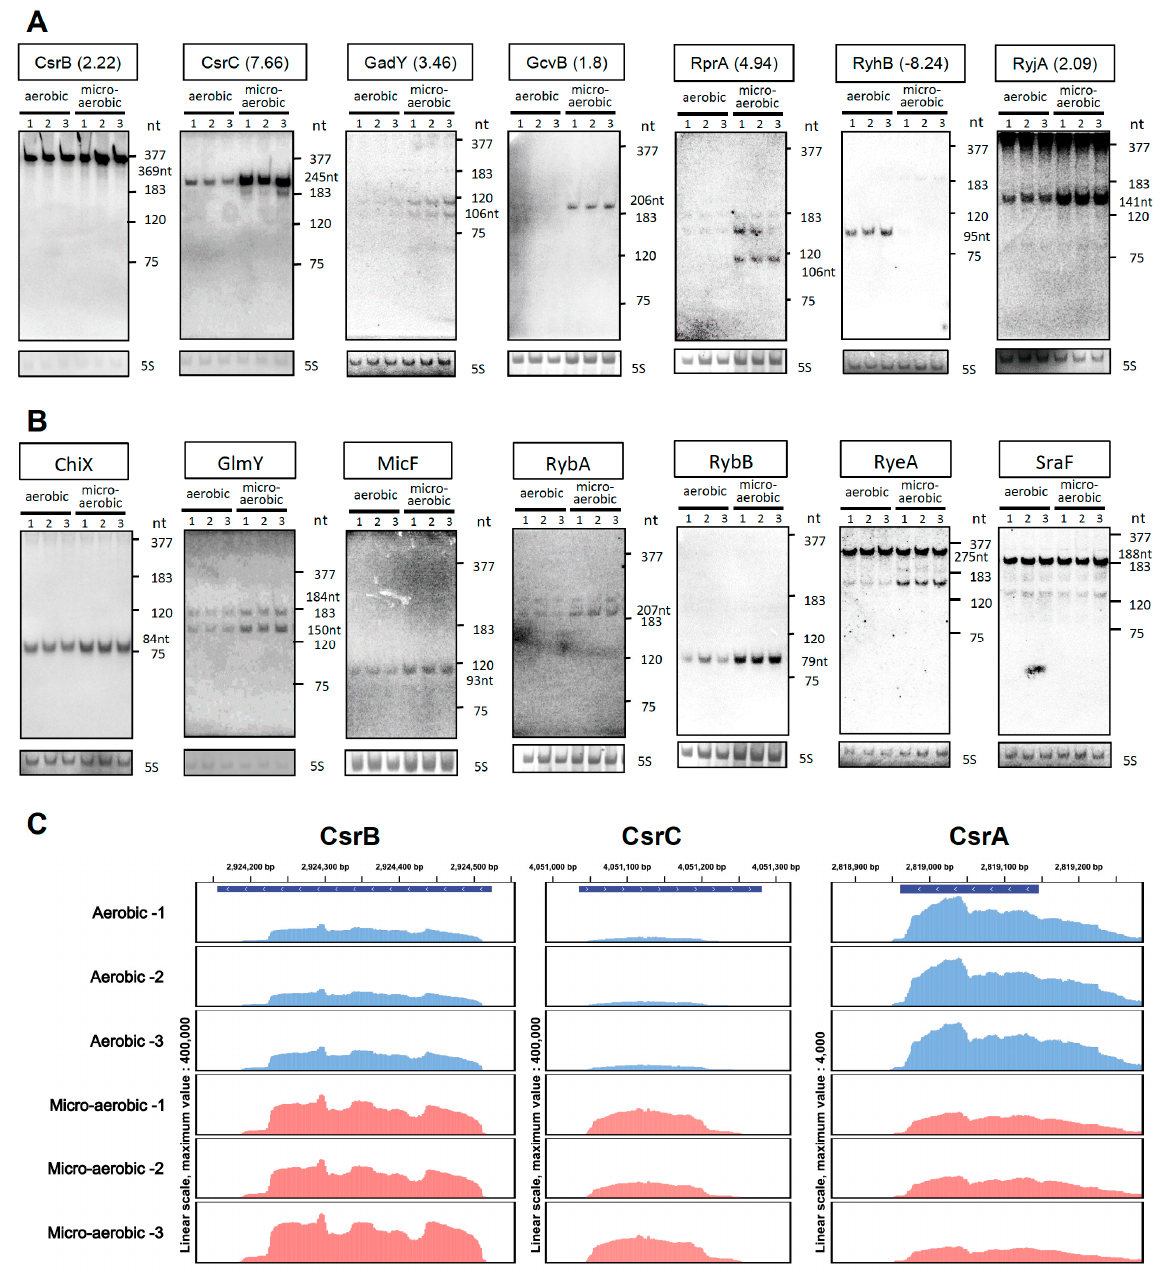
Figure 3. Higher fold-change expression and individual TPM values for known E. coli sRNAs de- tected under microaerobic versus aerobic conditions. ( A ) The fold-change values for upregulated and downregulated sRNAs are shown in red and green, respectively. ( B , C ) The y axis shows loga- rithmic TPM expression values for sRNAs expressed in aerobic ( B ) and microaerobic ( C ) cultures, respectively. The x axis shows the sRNAs listed in ( A ). The individually colored bars represent dif- ferent biological replicates as indicated.